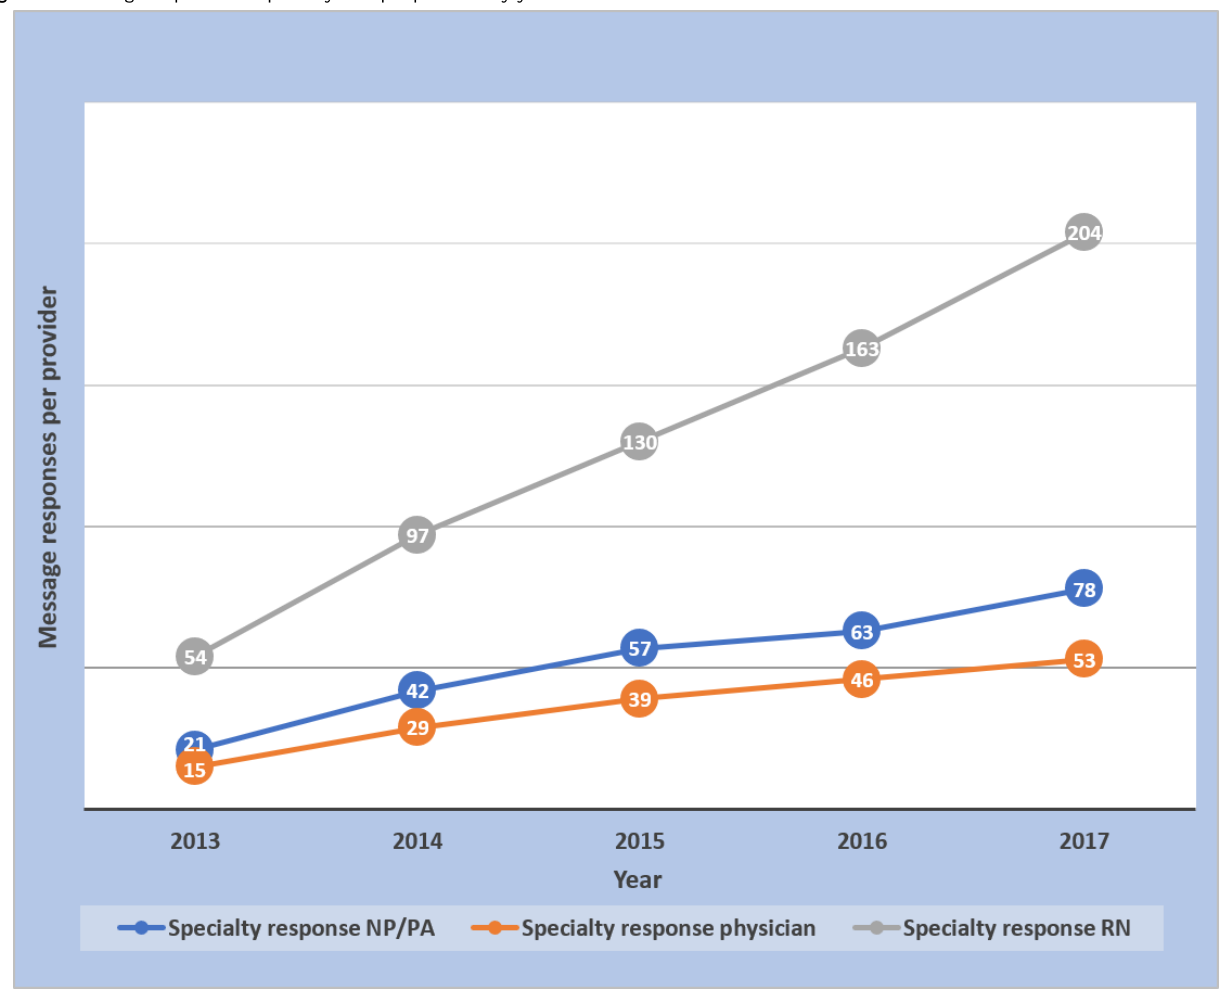
Figure 5. Message responses in specialty care per provider by